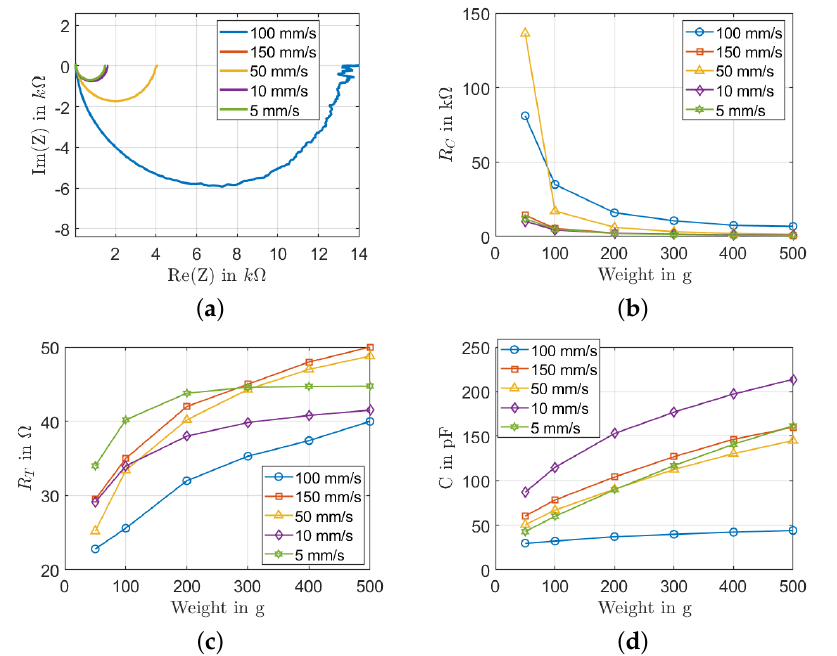
Figure 8. Influence of the squeegee speed: ( a ) Nyquist plot for a load of 300 g; ( b ) R C change with different loads; ( c ) R T change with different loads; ( d ) C change with different